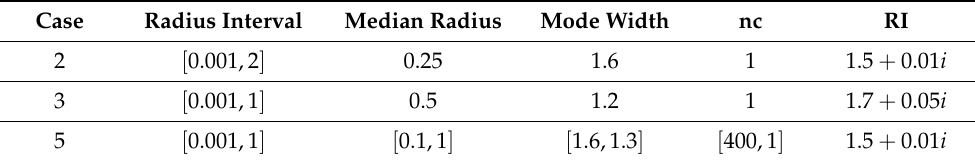
Table 1. Simulation parameters for preliminary tests for spherical particles, η = 1, (nc: number